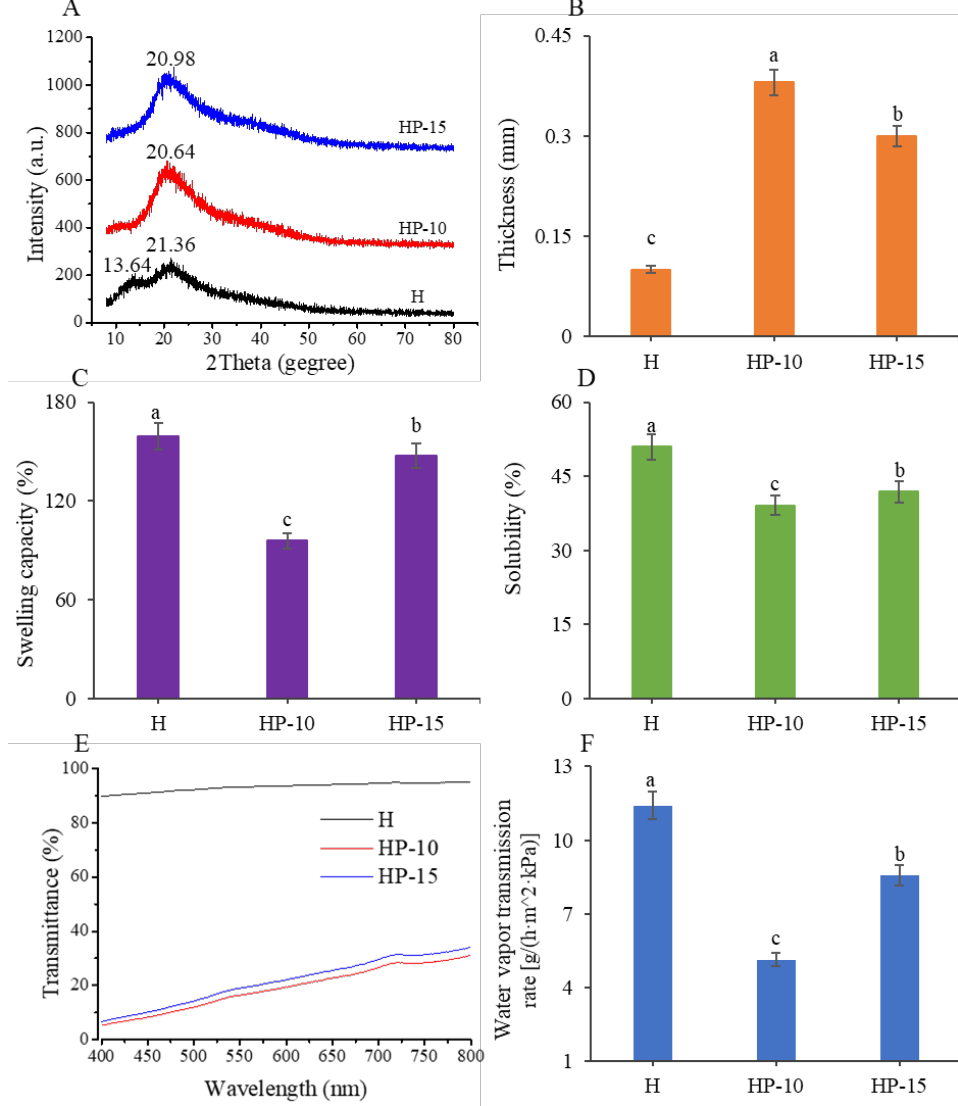
Figure 3. Analysis of physical properties of the films. ( A ) The XRD patterns, ( B ) thickness, ( C ) swelling capacity, ( D ) water solubility, ( E ) light transmittance, and ( F ) water vapor transmission rate of the films (CK: control; H: 2% sodium alginate + antibacterial agents; HP-10: 2% sodium alginate + antibacterial agents + 1:10 protein solution; HP-15: 2% sodium alginate + antibacterial agents + 1:15 protein solution). Different lowercase letters indicated significant differences at p < 0.05.